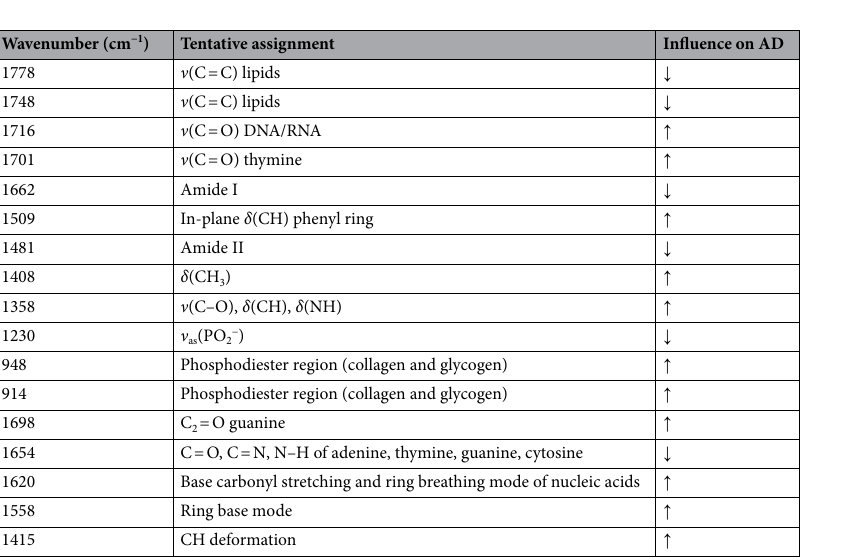
Table 5. Potential spectral biomarkers for distinguishing active disease and disease remission using plasma samples based on the PLS-DA coefficients ( ν = stretching; δ = bending).